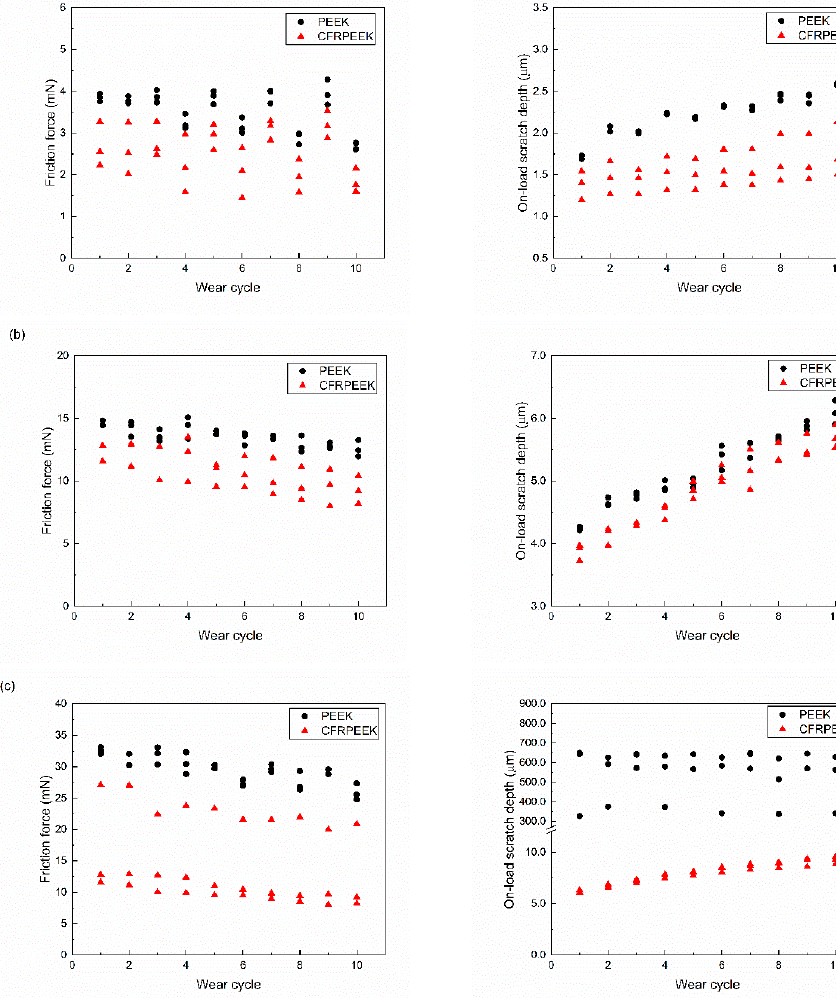
Figure 3. The evolution of friction force (left) and on-load wear depth (right) of PEEK and CFRPEEK under different applied load: ( a ) 10 mN, ( b ) 30 mN, and ( c ) 60